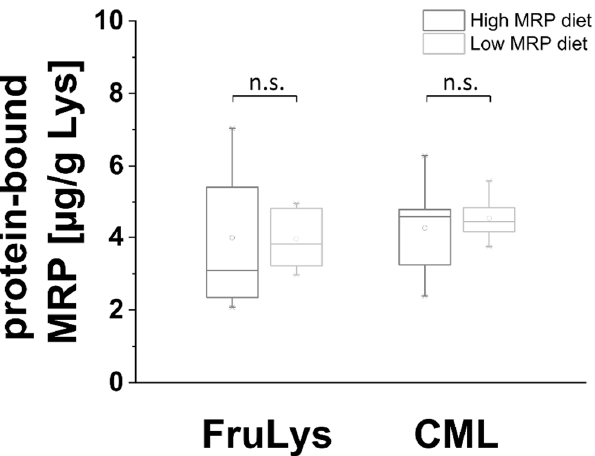
Figure 5. Boxplot of protein-bound FruLys and CML concentrations in the salivary protein fraction of five subjects during low or high MRP diet (sampling on d 3). The box contains 50% of data and includes the mean of the data (demonstrated by the dot in the box) and the median (demonstrated by the line in the box). Significance: n.s.—not